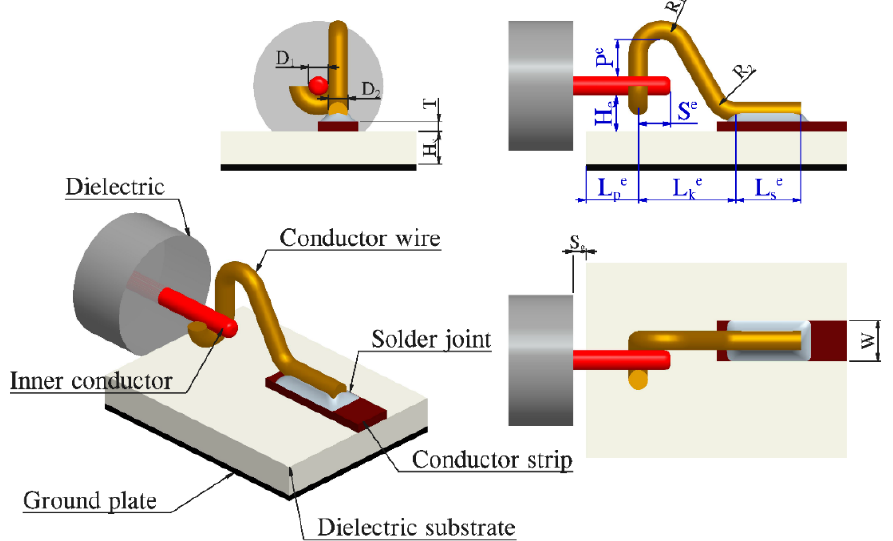
Figure 1. Composition and configuration parameterization of flexible conductor wire interconnection (FCWI). Table 1. Configuration parameters and dielectric properties of FCWI. Components Configuration Characteristics Parameters Conductor wire